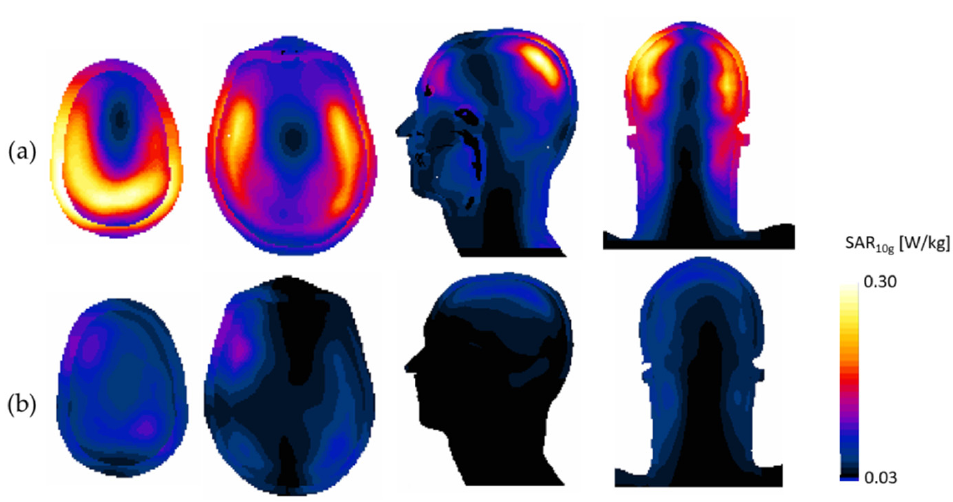
Figure 5. SAR 10g maps in the axial, sagittal, and coronal views of a human model for ( a ) head BC coil and ( b ) yurt BC coil.